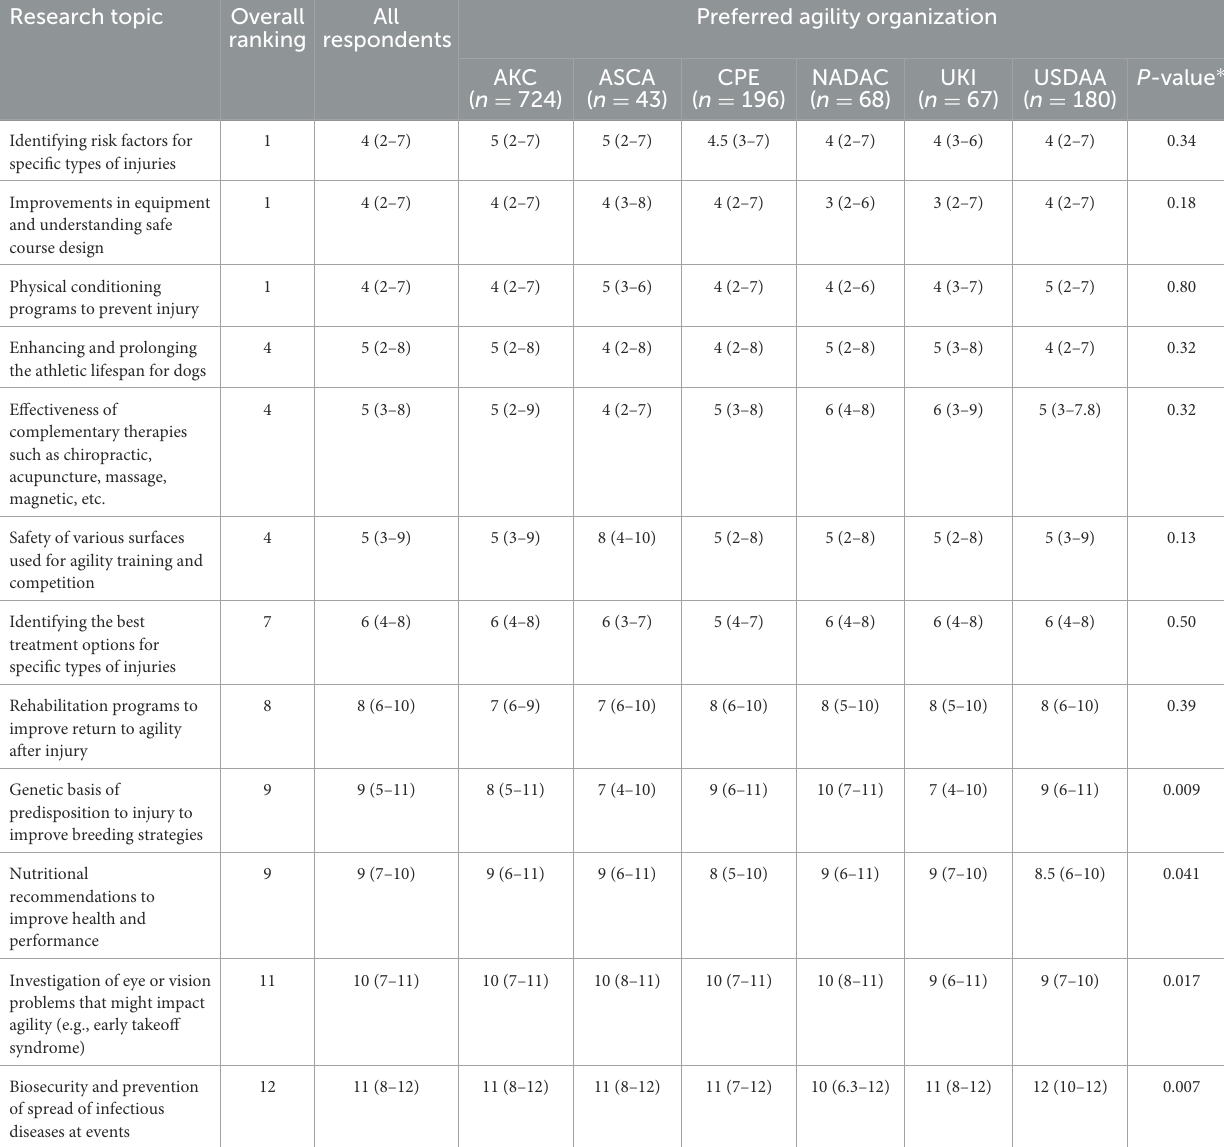
TABLE 6 Median (IQR) priority rankings for each research topic as provided by all respondents or by specified subsets of respondents. Research